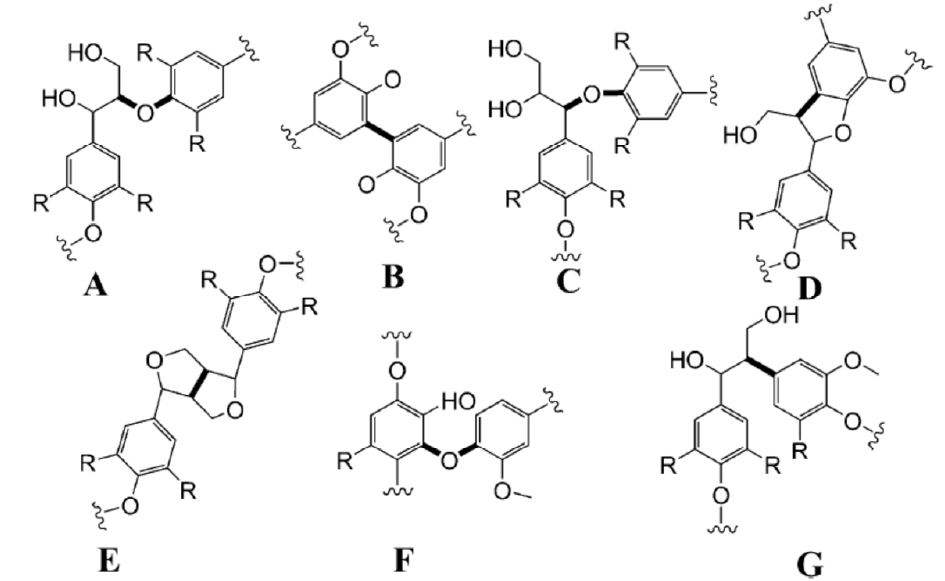
Figure 2. Main structural moieties in lignin structure: ( A ) β - O -4, ( B ) 5-5, ( C ) α - O -4, ( D ) β -5, ( E ) β - β , ( F ) 4- O -5, and ( G ) β -1. (Reprinted from [22] Copyright 2011, with permission from John Wiley and Sons.)